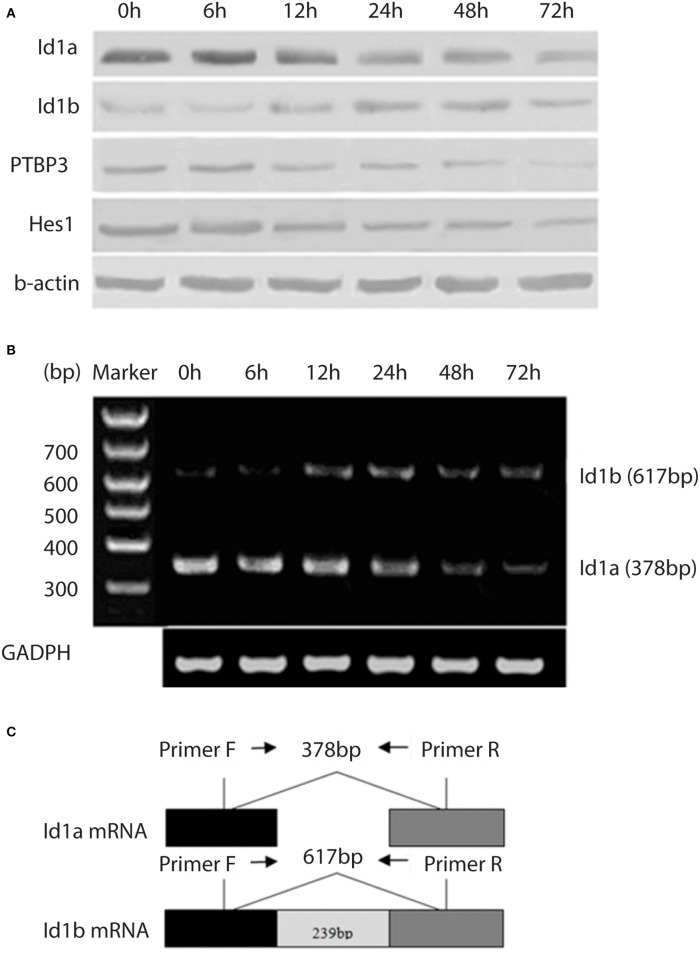
Expression of Id1a, Id1b, PTBP3, and Hes1 in the differentiating gastric cancer cells. (A) Western blot analysis of Id1a, Id1b, PTBP3, and Hes1 expressed in NaBU-treated MKN45 cells. The cells were treated with 3 mM NaBU for 6–72 h. (B) RT-PCR was performed to display the relative levels of Id1a and Id1b mRNAs in NaBU-treated MKN45 cells. (C) The map showed the primer sites for RT-PCR. Id1a and Id1b proteins differ at the C-terminus due to differential splicing of the 239 bp intron (sequence from NCBI).